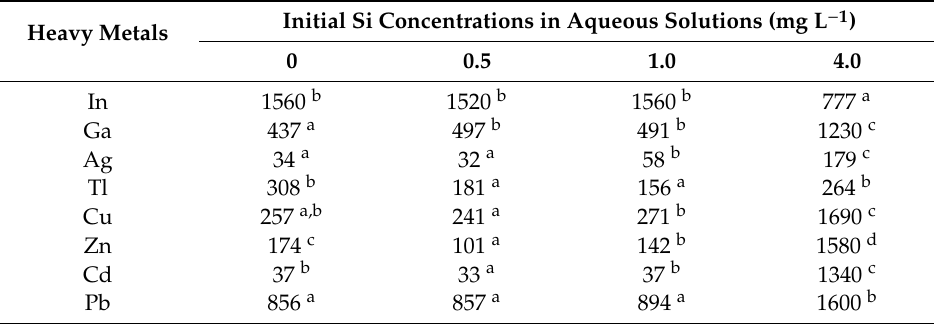
Table 3. Bioconcentration factors of E. acicularis after 21 days of the experiment Heavy